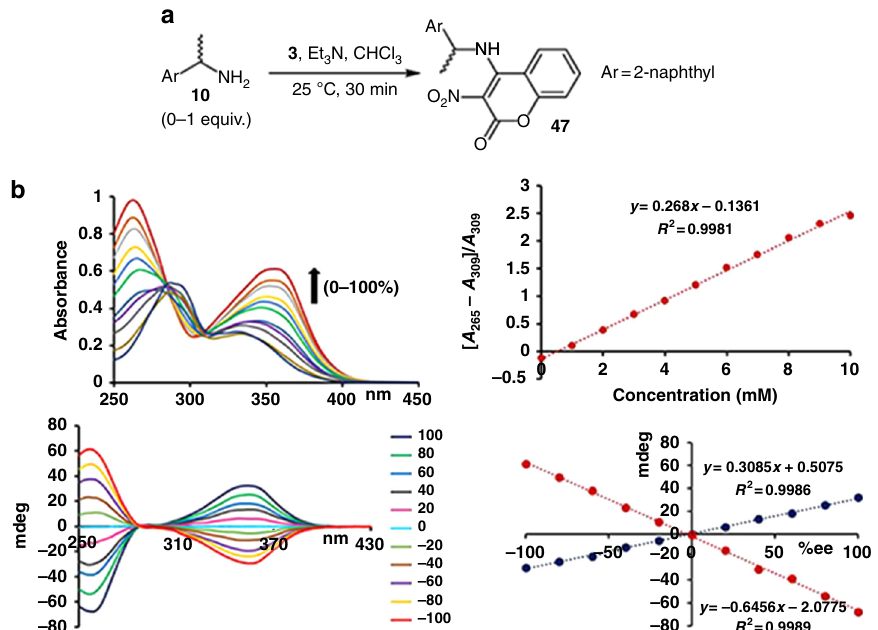
Fig. 3 Chiroptical sensing of 10 . a UV response of 3 to varying amounts of 10 . b CD response of 3 to nonracemic samples of 10 and linear correlation between the induced CD signals at 257 (red) and 355 (blue) nm and the sample